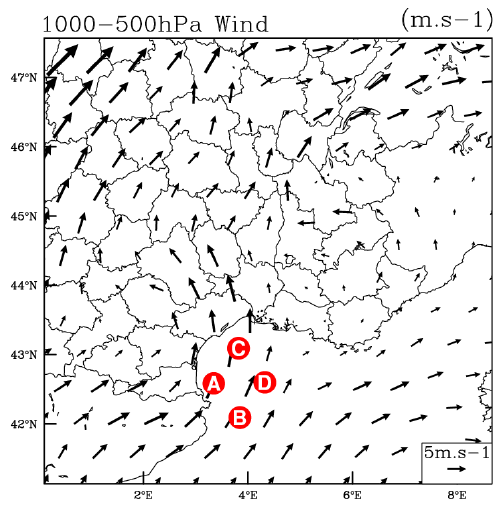
Fig. 11. Location of the centre of gaussian perturbations (red cir- cles) for the E5 ensemble (Gard-H´erault case). Arrows show the 1000-500 hPa vertically-averaged wind at 00 UTC 20 October.